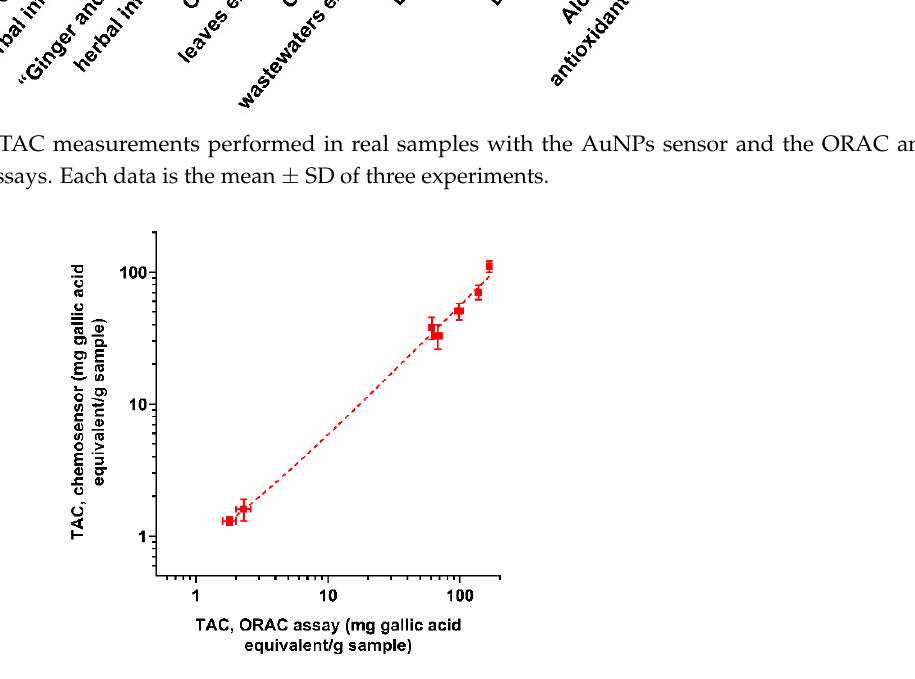
Figure 6. Correlation between the TAC values measured for real samples with the chemosensor and the ORAC reference assay. Each value is the mean ± SD of three experiments. Parameters of the linear regression are slope = 0.56, Y-intercept = 0.31, R 2 =